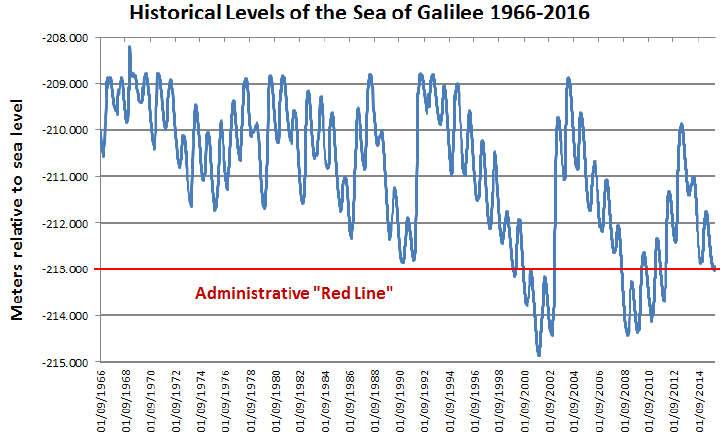
Figure 1. Historical levels of the Sea of Galilee (09/1966–01/2016). Based on Data from [40].